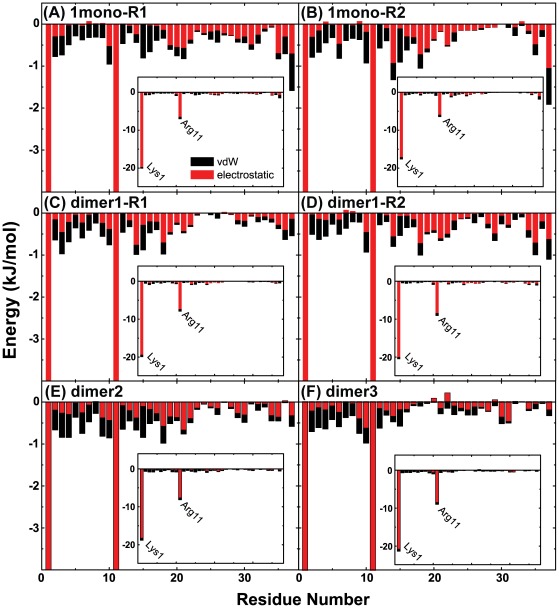
The interaction energy of each individual hIAPP residue with POPG lipid bilayer (per lipid).To show the total interaction energy of Lys1/Arg11 with POPG lipid, the interaction energy using a different scale is given in the inset. The interaction energy is plotted for both monomer and dimer systems and is averaged over the last 50 ns for each MD run. The residue-based interaction energy is decomposed into the electrostatic and vdW terms.